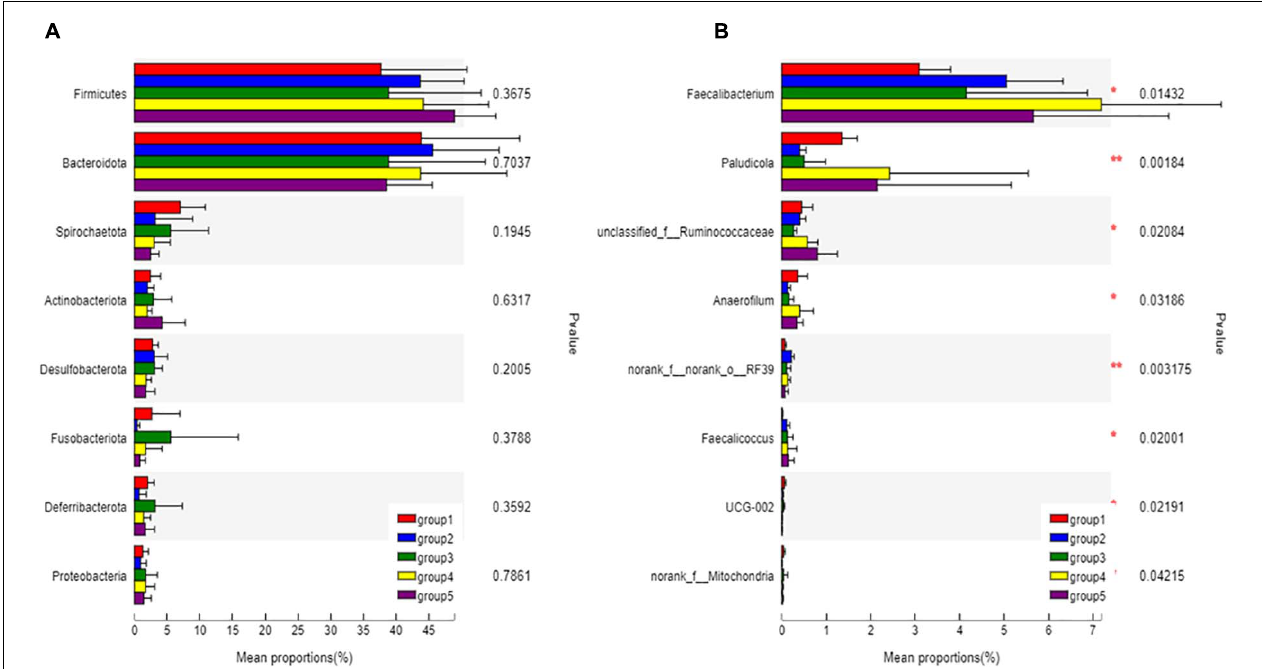
FIGURE 3 | Classification and differences in cecal microbial composition of ducks in different groups. The eight most abundant bacteria at the phyla level (A) and bacteria with significant difference at genus level (B) among five groups were showed. Relative abundance of altered cecal microbiota levels were tested under ANOVA and Tukey post hoc analysis. Significant correlations were marked by *0.01 < P < 0.05, **0.001 < P ≤